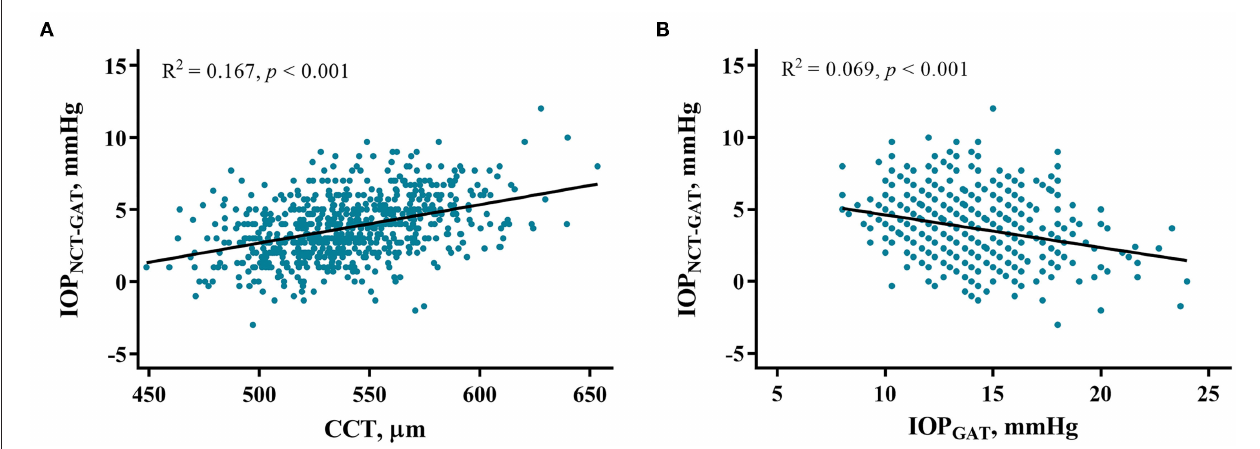
FIGURE 5 | Correlations between IOP NCT − GAT values and risk factors. Regression plots show central corneal thickness (CCT) (A) and IOP GAT value (B) effect on IOP NCT − GAT with R 2 = 0.167 and 0.069, respectively. The full lines indicate regression lines. IOP GAT , intraocular pressure measured with Goldmann applanation tonometer; IOP NCT − GAT , the difference of intraocular pressure measured with non-contact and Goldmann applanation tonometer.